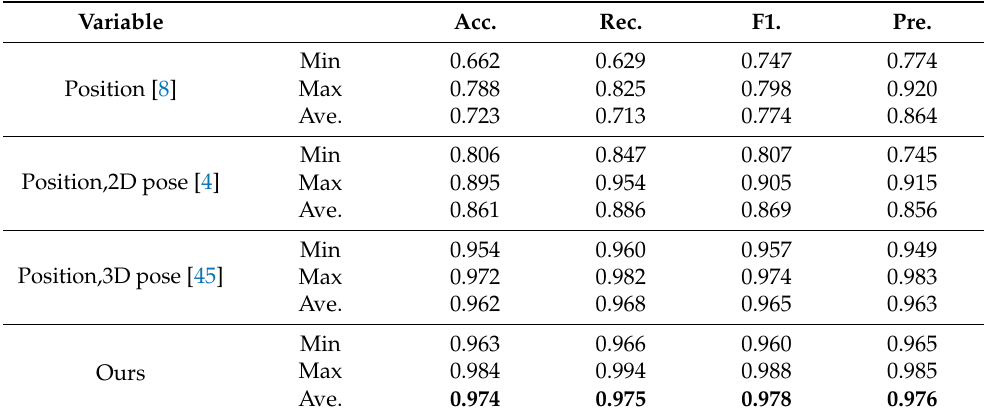
Table 5. Comparison of results for various input parameters when predicting pedestrian hazardous crossing intention. Recognition Accuracy (Acc.), Recall (Rec.), F1-score (F1.), Precision (Pre.). Min, Max, and Average (Ave.) results. Variable Acc. Rec. F1. Pre.